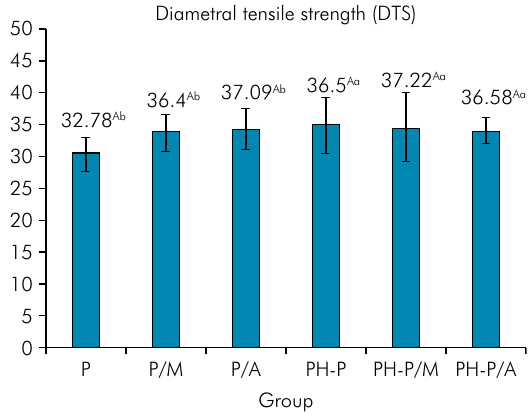
Figure 1. Results of the diametral tensile strength test.